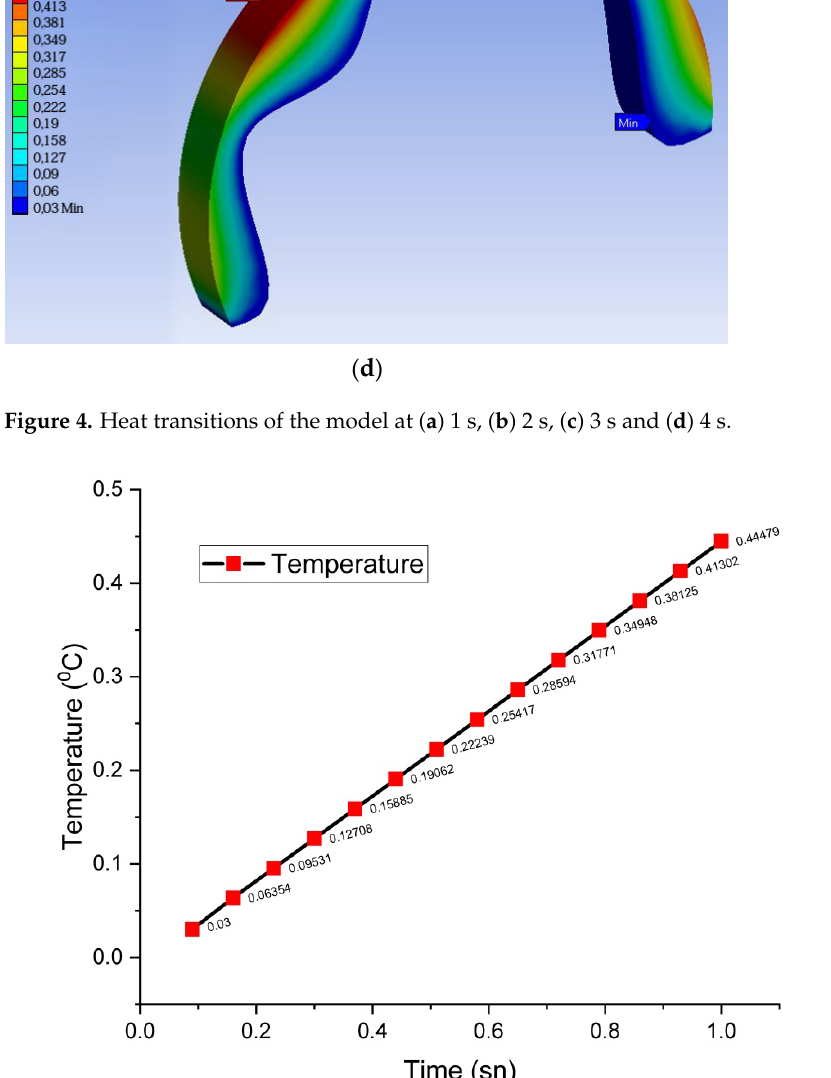
Figure 5. Temporal change of model heat transfer.